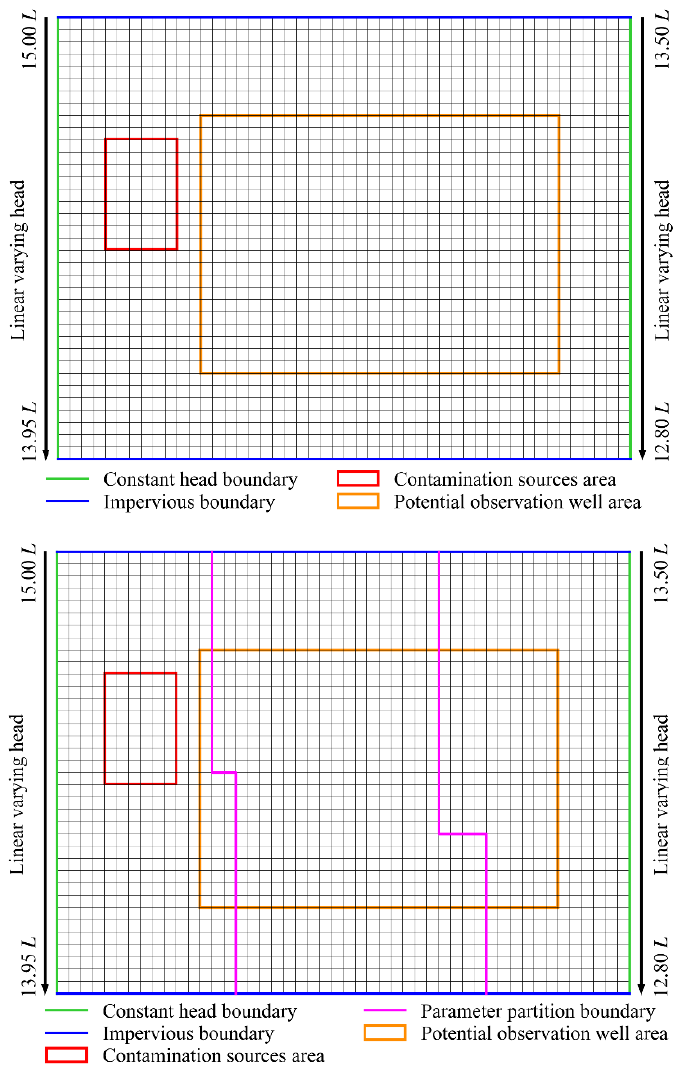
Figure 3. Discretization graph of groundwater flow field for Case 1 ( upper ) and Case 2 ( lower ).